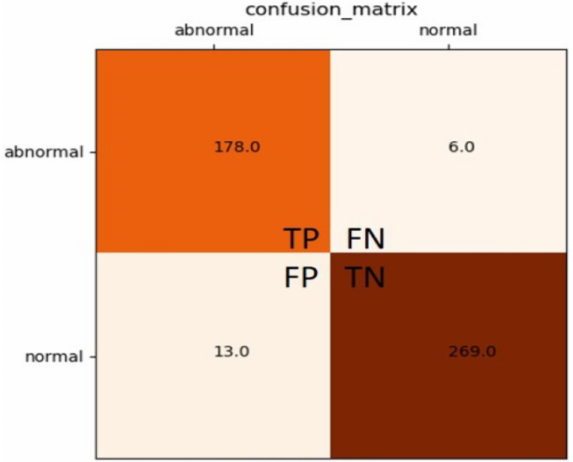
Figure 5. Output confusion matrix of the multilayer CNN-based